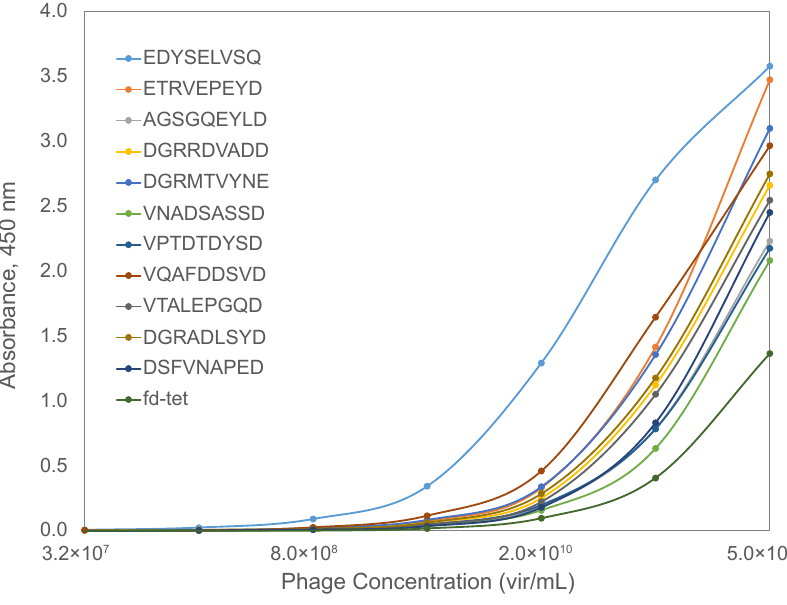
Figure 10. FGFR3-binding phages displaying FGF1 mimotopes as characterized by an indirect ELISA. Serial dilutions of phages were incubated with the bound FGFR3 receptor, followed by incubation with a rabbit anti-phage IgG and an HRP-conjugated goat anti-rabbit IgG. Signal was produced using a TMB substrate and endpoint absorbance at 450 nm was measured after a 30-min incubation. Candidate FGFR3-binding phages were compared to the wildtype fd-tet phage (dark